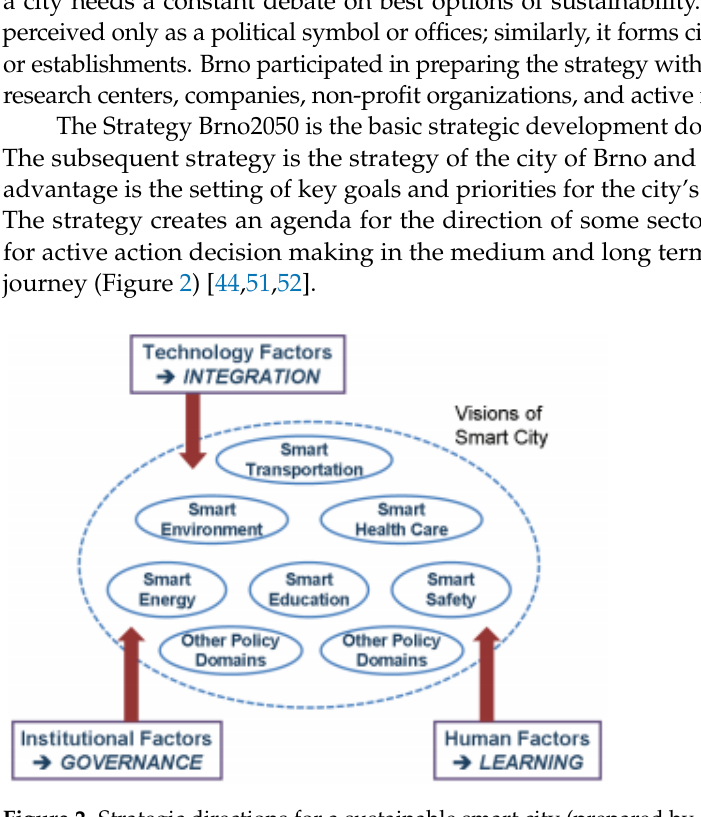
Figure 2. Strategic directions for a sustainable smart city (prepared by authors)